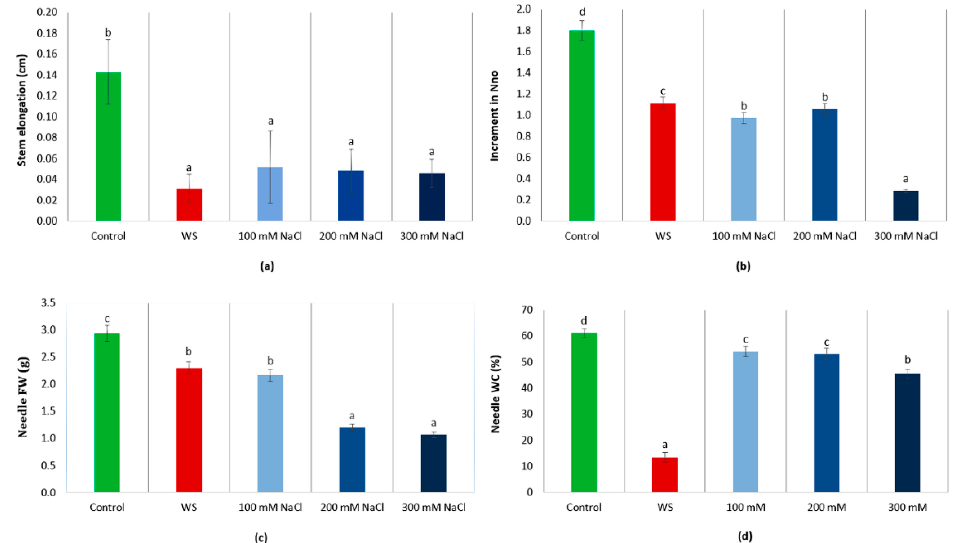
Figure 1. Effect of water and salt stress treatments on growth inhibition in A. alba . Stem elongation ( a ), increment in the number of needles (Nno) ( b ), needle fresh weight (FW) ( c ), needle water content (WC%) ( d ) of one-year-old A. alba seedlings after 30 days of growth in the presence of the indicated salt concentrations or subjected to water deficit (completely withholding irrigation) (WS). Stem length and number of needles’ measurements were taken just before starting the treatments (time 0), and before collecting the samples (time 30). Bars represent means ± SE ( n = 7). Different letters above the bars indicate significant differences between treatments, according to Tukey’s test ( α = 0.05).